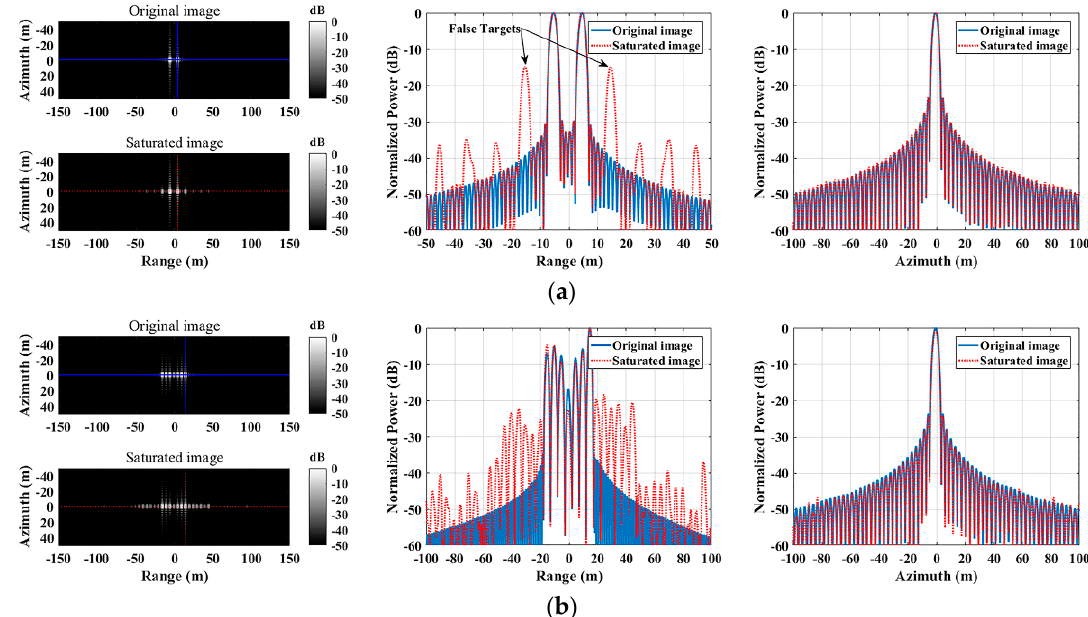
Figure 9. Normalized imaging results for saturated raw data. The traditional sidelobes are suppressed by the Hamming window. ( a ) Two point targets cause false images. The main lobes of the real targets exhibit no significant degradation. ( b ) A series of isolated points result in a parasitic sidelobe.